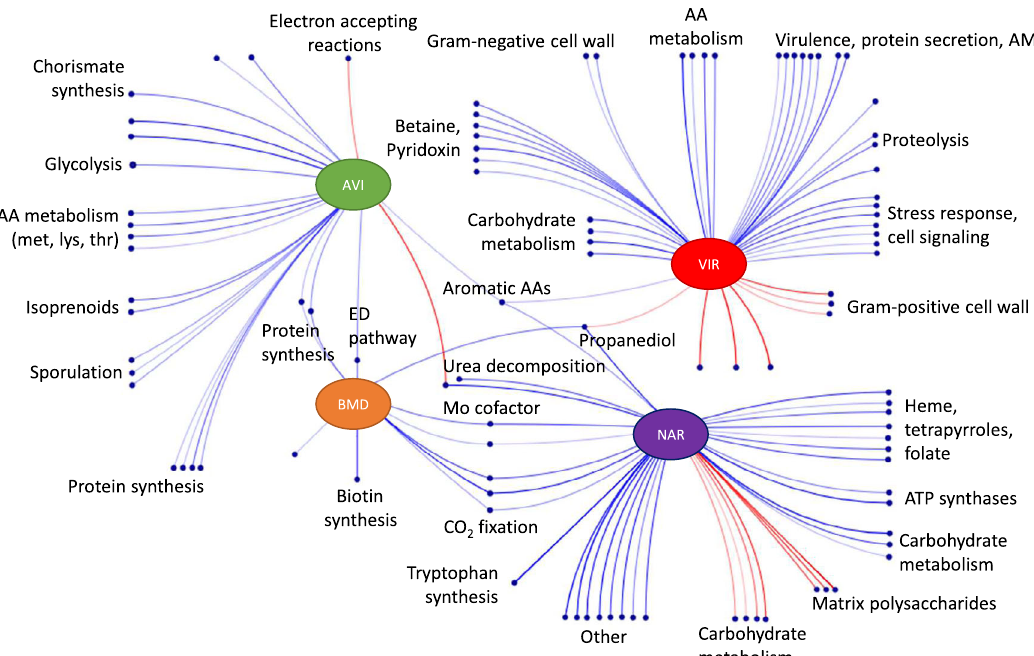
Fig. 2 Major functional categories enriched or depleted in response to AGP relative to controls in the cecal microbiome. Each dot represents a set of functional roles signi fi cantly enriched or depleted relative to controls (FDR < 0.15). Blue lines connect AGP to signi fi cantly enriched processes according to Gene Set Enrichment Analysis (GSEA). Red lines connect AGP to signi fi cantly depleted processes. Labels capture the common functionality in select clusters of enriched terms (see Supplementary Data 3 for the full list of terms). AVI avilamycin, VIR virginiamycin, NAR narasin, AA amino acid, ED Entner Duodoroff, Mo